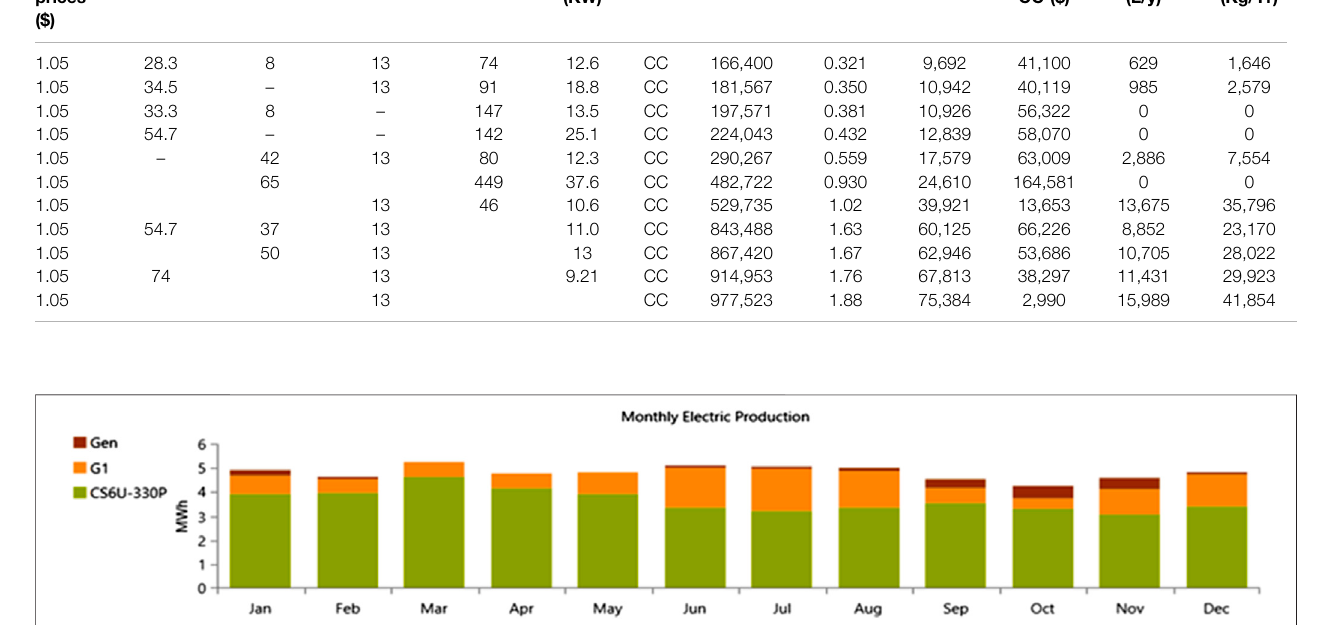
FIGURE 6 | Monthly electricity production from solar, wind, and diesel generators